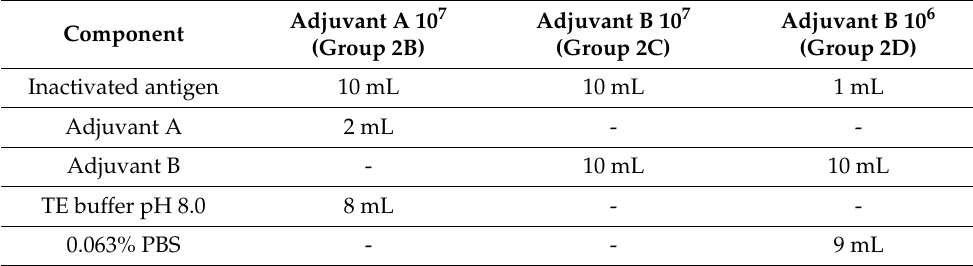
Table 1. Vaccine preparation. TE buffer was used to compensate different volumes of added adjuvants. Dilution of antigen for testing of different amounts was performed using phosphate buffered saline